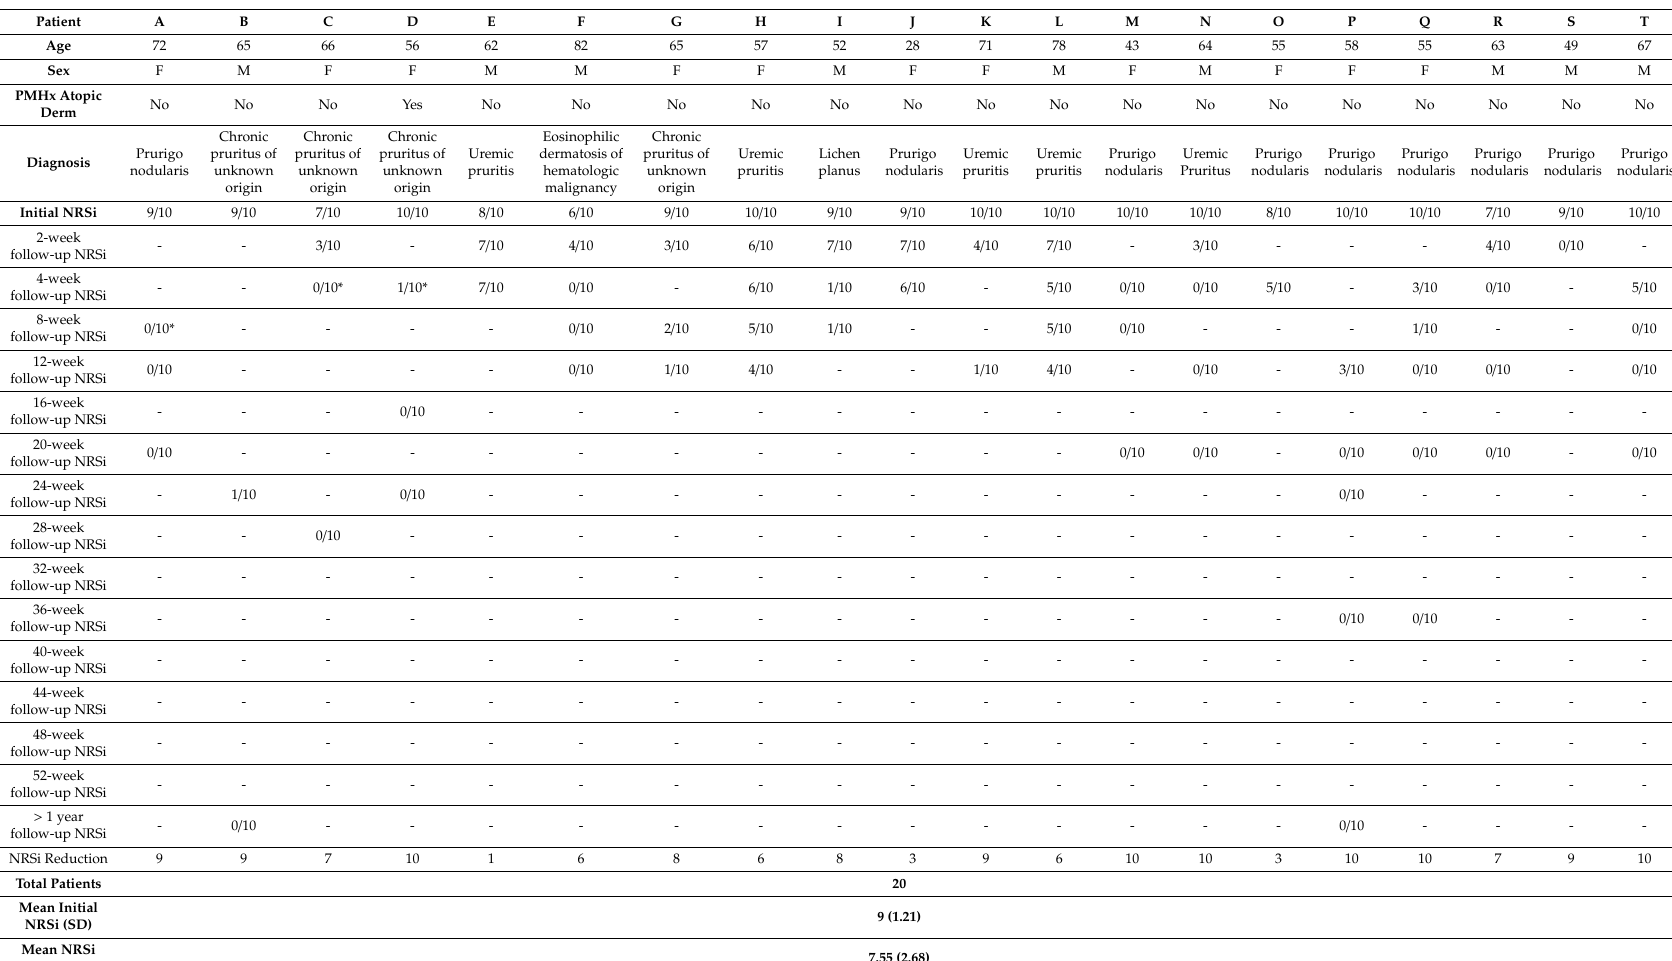
Table 1. Summary